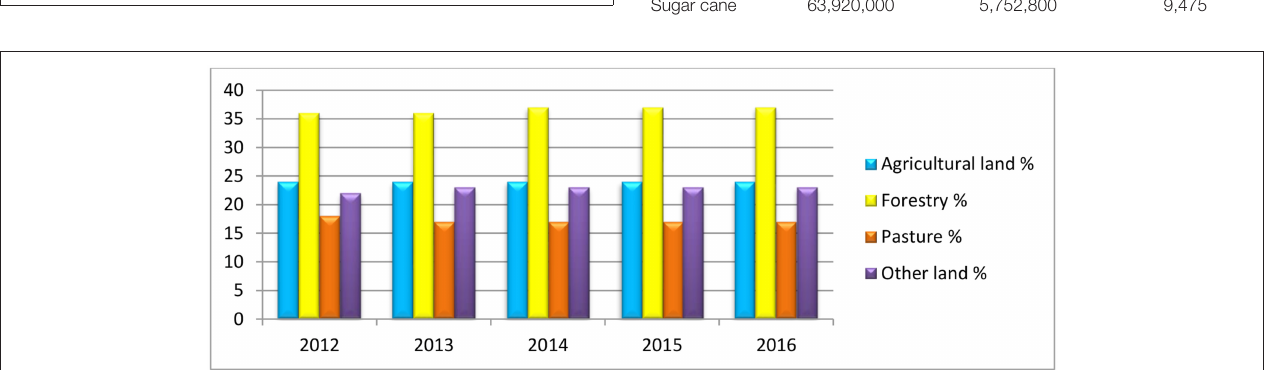
FIGURE 6 | Types of biomass feedstocks.